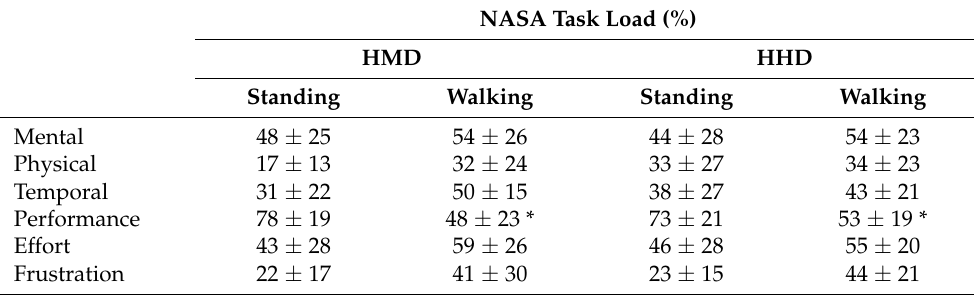
Table 2. NASA Task Load Index items: mental, physical and temporal demand; performance; effort; and frustration in % for dual tasking on head-mounted displays (HMDs) and hand-held displays (HHDs) during standing and walking. * sig. different to standing within condition ( p < 0.05). NASA Task Load (%) HMD HHD Standing Walking Standing Walking Mental 48 ± 25 54 ± 26 44 ± 28 54 ± 23 Physical 17 ± 13 32 ± 24 33 ± 27 34 ± 23 Temporal 31 ± 22 50 ± 15 38 ± 27 43 ± 21 Performance 78 ± 19 48 ± 23 * 73 ± 21 53 ± 19 * Effort 43 ± 28 59 ± 26 46 ± 28 55 ± 20 Frustration 22 ± 17 41 ± 30 23 ± 15 44 ±